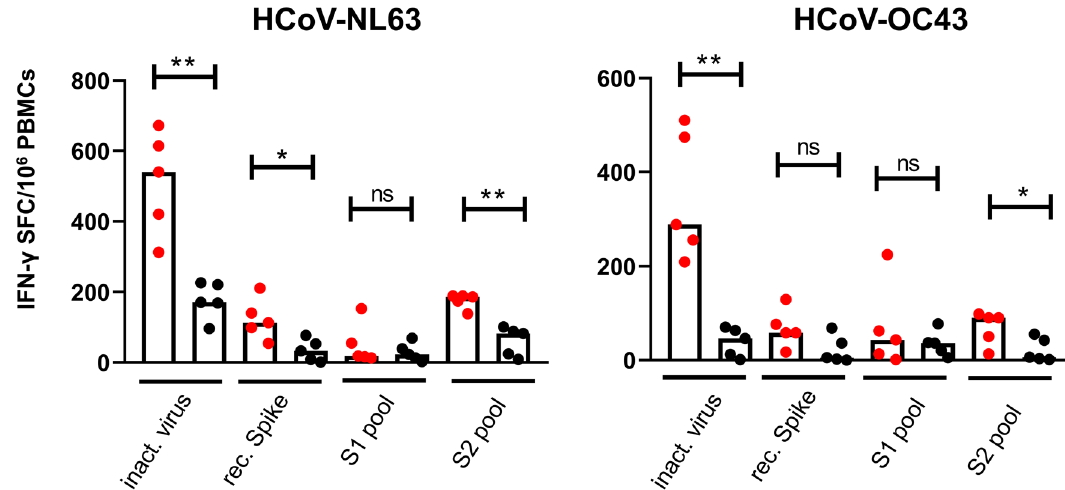
Figure 2. S protein-specific T cell immune responses in young and older subjects. PBMCs from HCoVs high-responders, 5 young (red dot) and 5 older (black dot) adults, were cultured in the presence of NL63 and OC43 inactivated virus (inact. virus; 2.5 µg/ml) recombinant spike proteins (rec. Spike; 2.5 µg/ml) or peptide pools (S1 and S2; 0.4 µg/ml each peptide) and frequency of IFN-γ producing T cells measured by ELISpot. Data were background-subtracted and expressed as SFC/10 6 PBMCs. Each dot represents a single subject. Statistical comparison between the two groups was performed using non-parametric Mann–Whitney test for unpaired samples (**p = 0.0079; *p < 0.05; ns: not